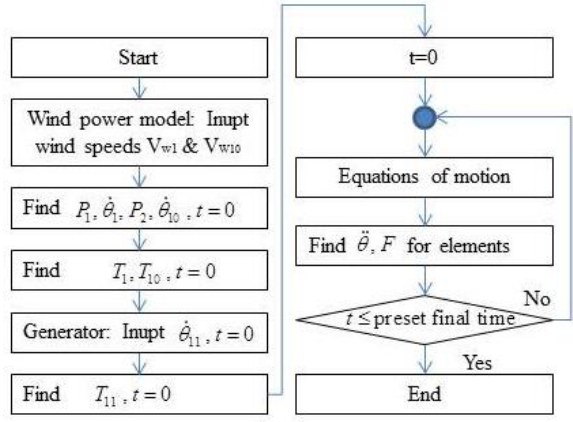
Figure 7. Computational algorithm.